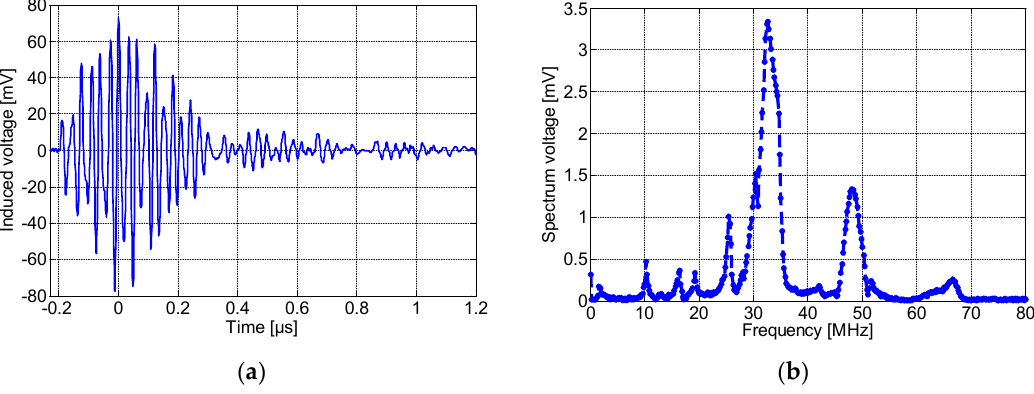
Figure 12. ( a ) The time-domain wave due to partial discharges at 8.2 kV and ( b ) its frequency spectrum detected by the spiral when placed at 10 cm away from the defective cable.